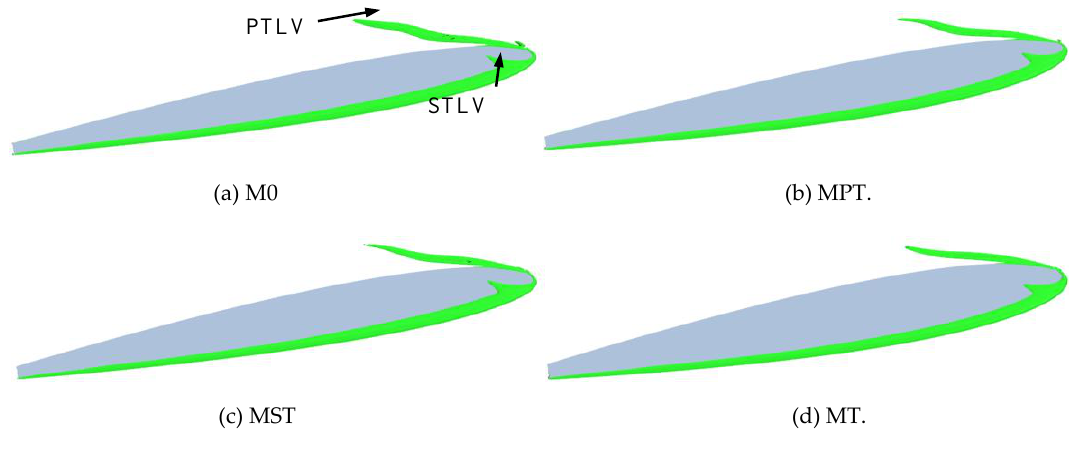
Figure 8. Iso-surface showing TLV at Q = 3 × 10 7 s -2.